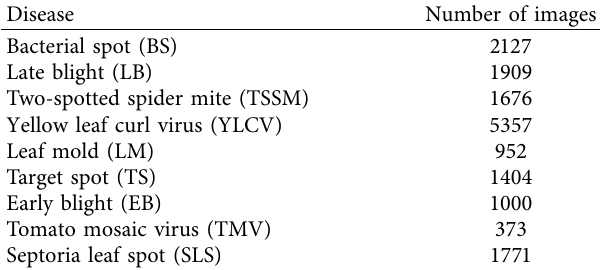
Table 1: Number-wise distribution of the PlantVillage database.